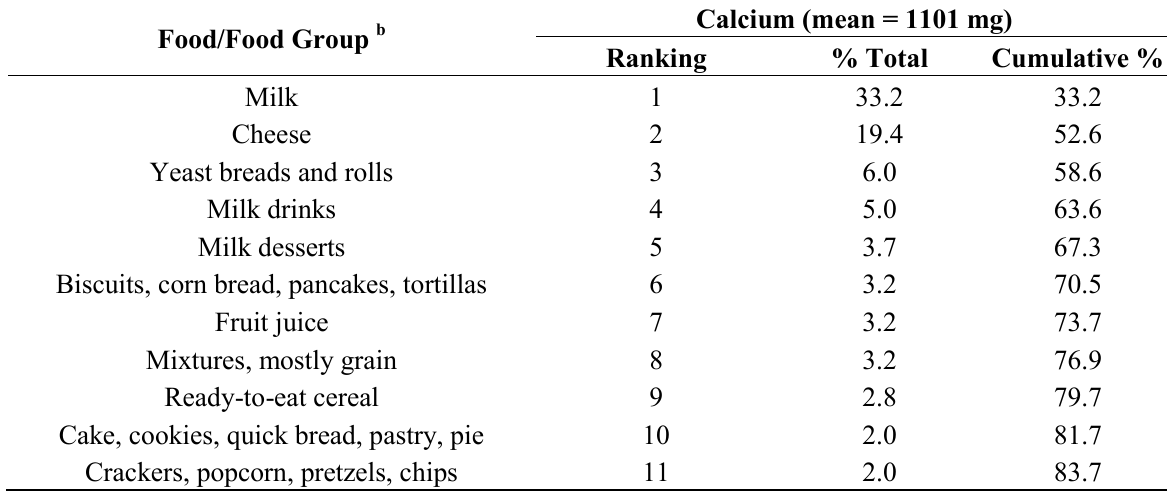
Table 11. Food/Food group sources of calcium among US children aged 2–18 years (from NHANES 2003–2006) a .